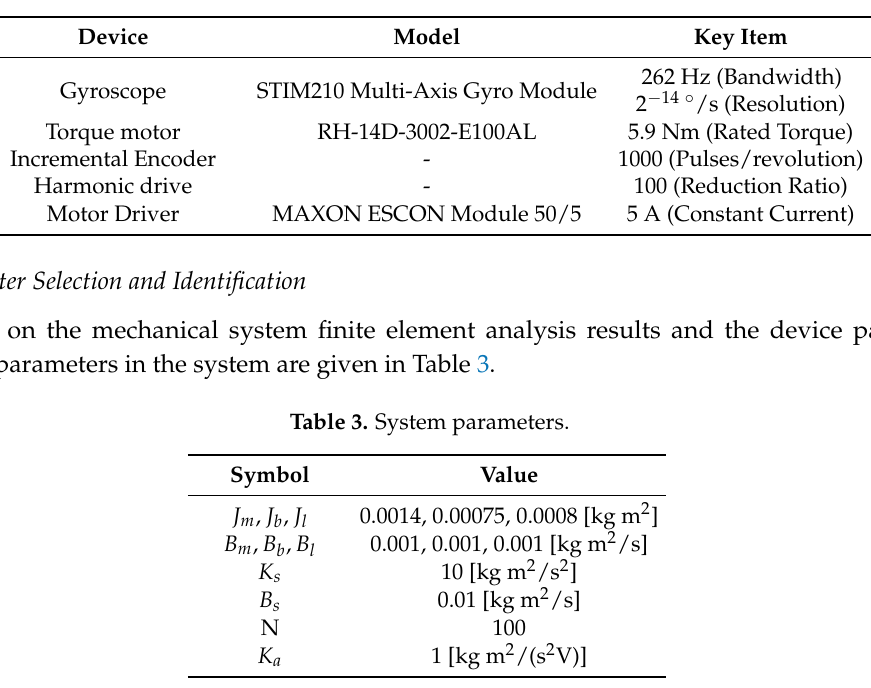
Table 2. Main devices used in the experiment.